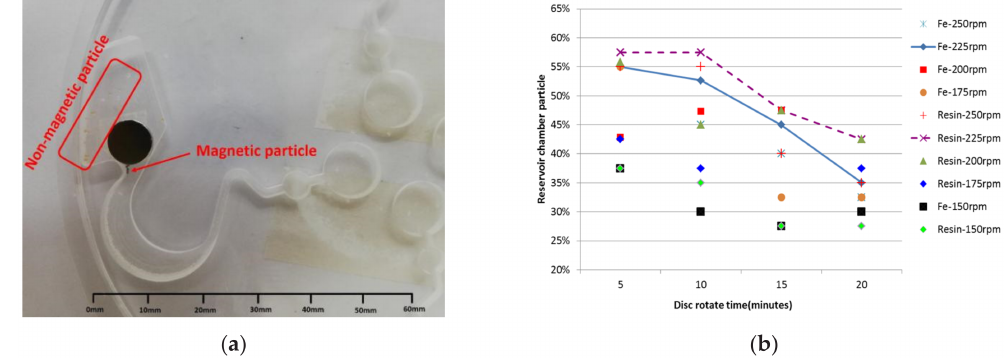
Figure 7. Magnetic and non-magnetic particles flowing to the reservoir chamber from the reaction chamber in the second setting. ( a ) Magnetic particles adsorbed in the capture chamber and non-magnetic particles flowing to the reservoir chamber. ( b ) Ratio of the magnetic particles (Fe) adsorbed in the capture